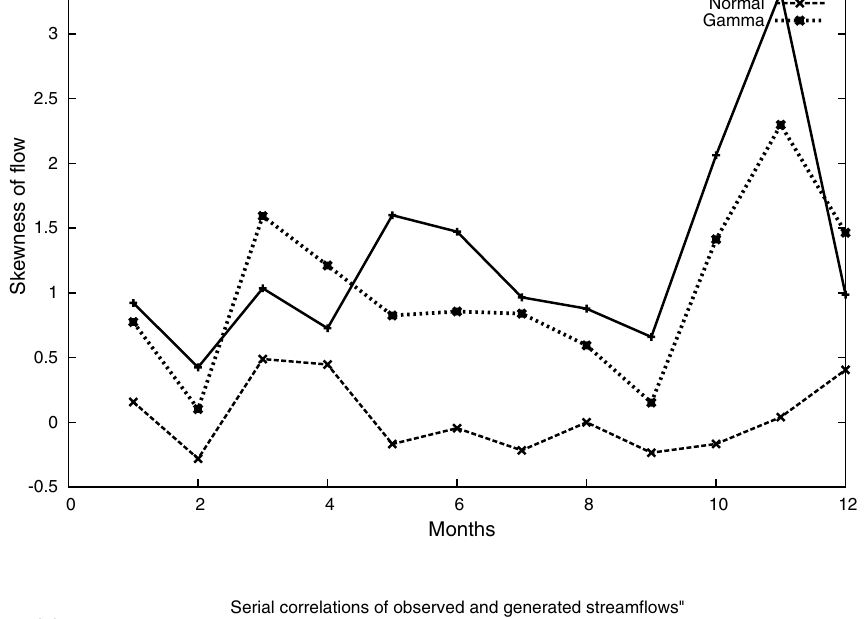
Fig. 13 Historical and generated monthly skewness coefficients of flows in Konar River (multi- site model)